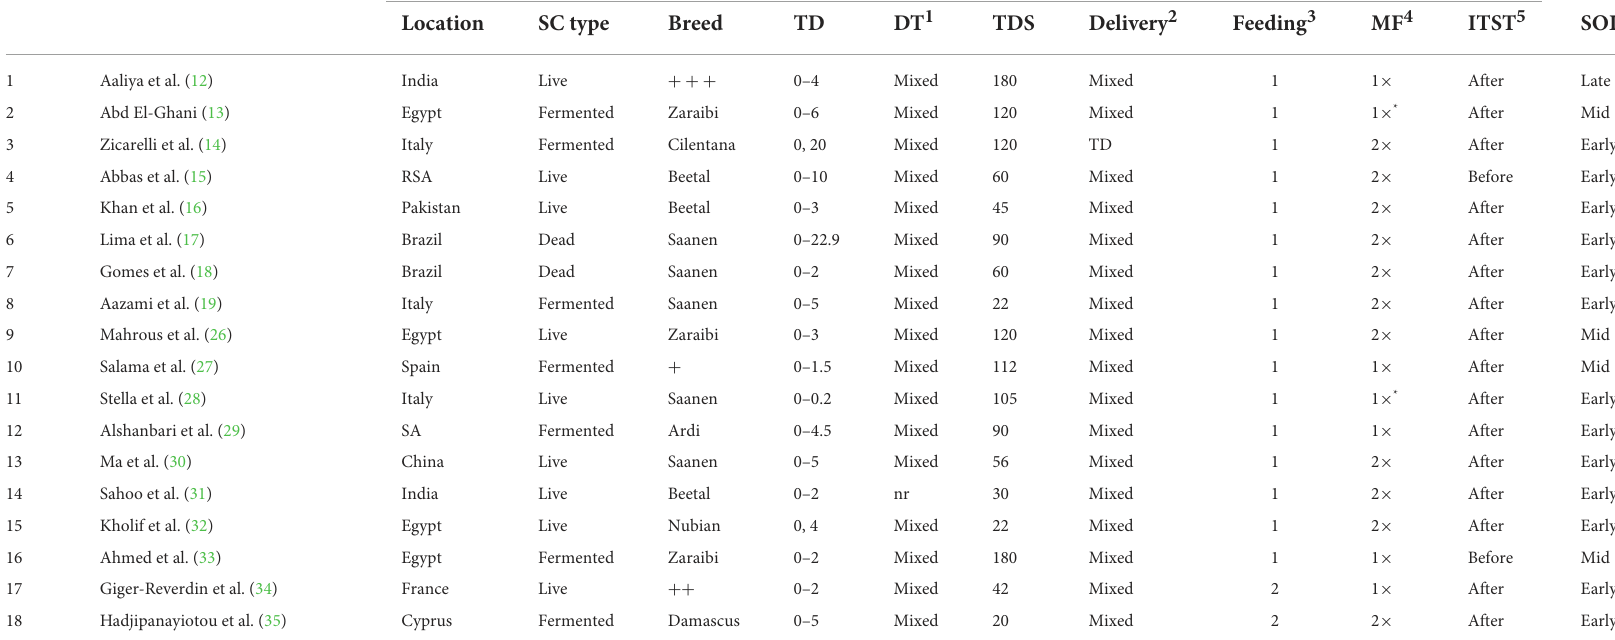
TABLE 2 Characteristics of studies included in the